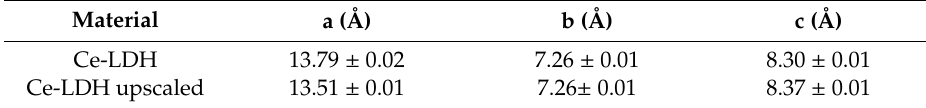
Table 1. Cell parameters of the orthorhombic lattice of the Ce-LDH and scaled-up Ce-LDH.